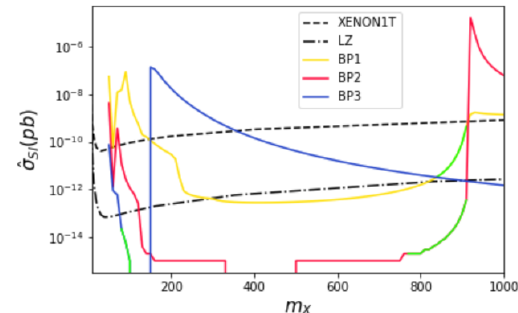
Figure 4 . DM spin independent scattering cross section with nucleons as function of m (cid:31) for benchmark points of table 1. The upper limits from XENON1T (dashed) and projected from LZ (dashed-dotted) experiments are shown for comparison. For each curve, the green segments are allowed by all theoretical and experimental